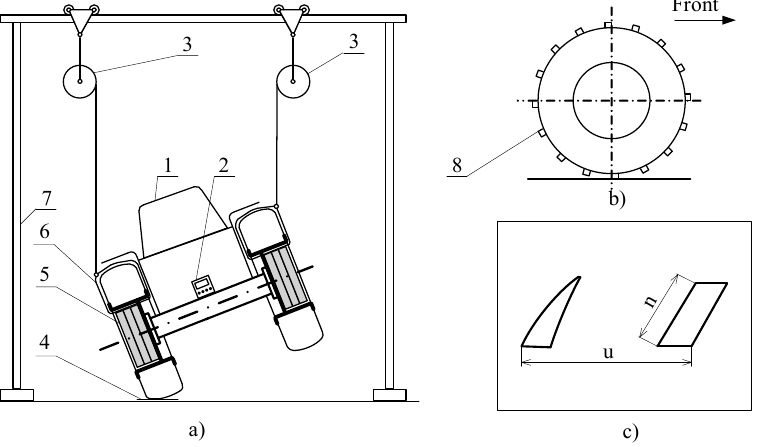
Figure 7. Analysis of tyre contact patch: ( a ) tractor at static overturning angle, ( b ) tyre position during experiments, ( c ) sketch of tyre contact patch on the paper sheet, 1—tractor, 2—digital protractor, 3—chain hoist, 4—sheet of paper, 5—ballast weight, 6—strap belt, and 7—portal.